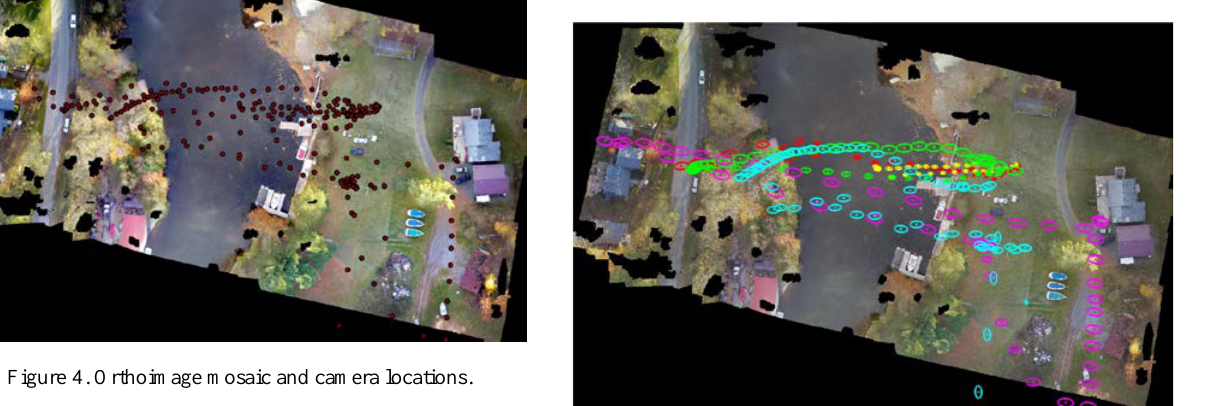
Figure 6. Location of the spectrometer footprints.